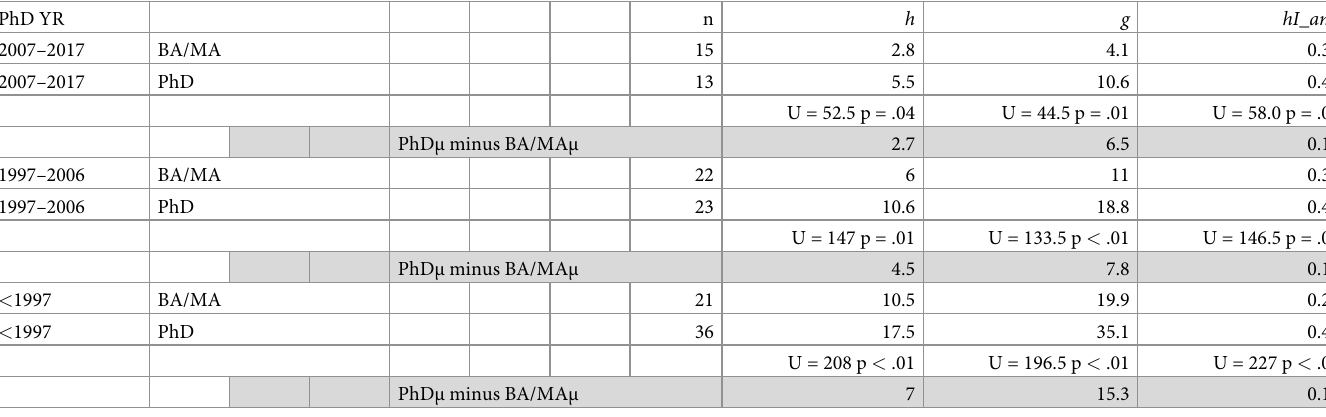
Table 4. Mean career index values by degree program, and difference between PhD and BA/MA means, by cohort. 1 . PhD YR